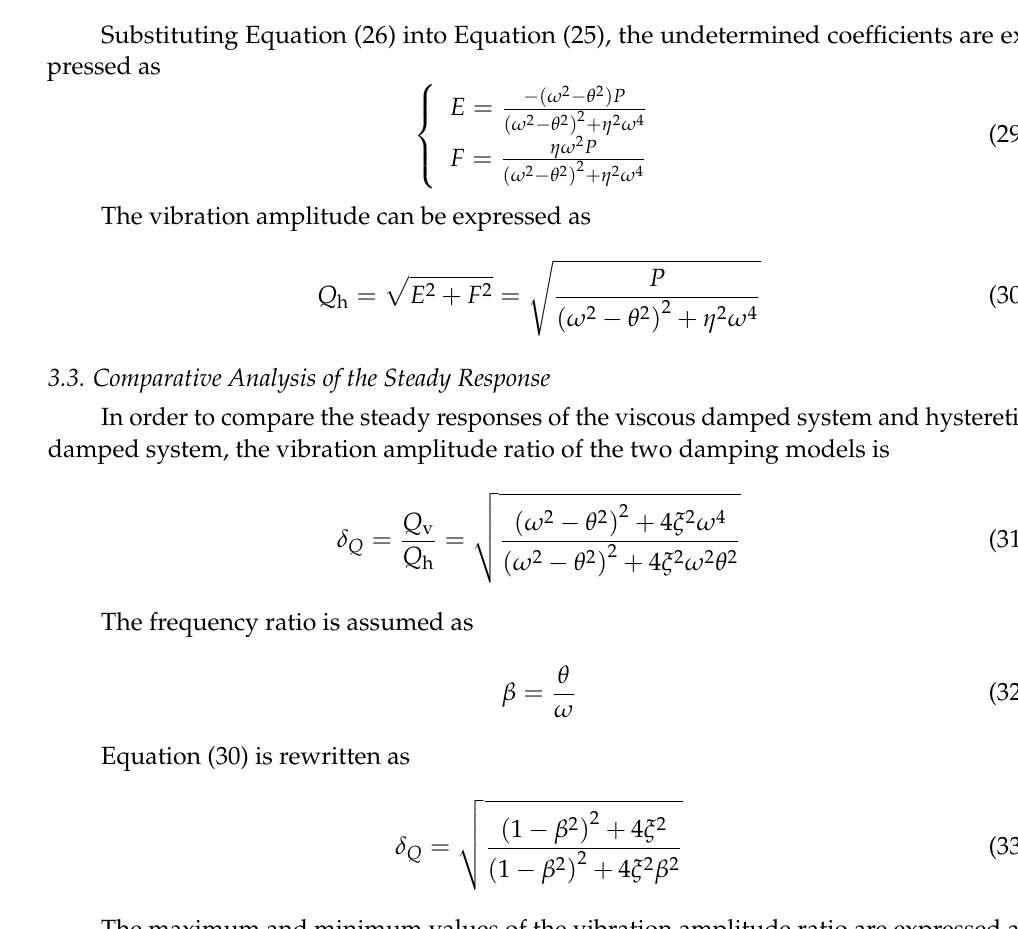
Figure 4. The hysteresis loops of hysteretic damping model: ( a ) hysteresis loop of resisting force; ( b ) hysteresis loop of damping force.